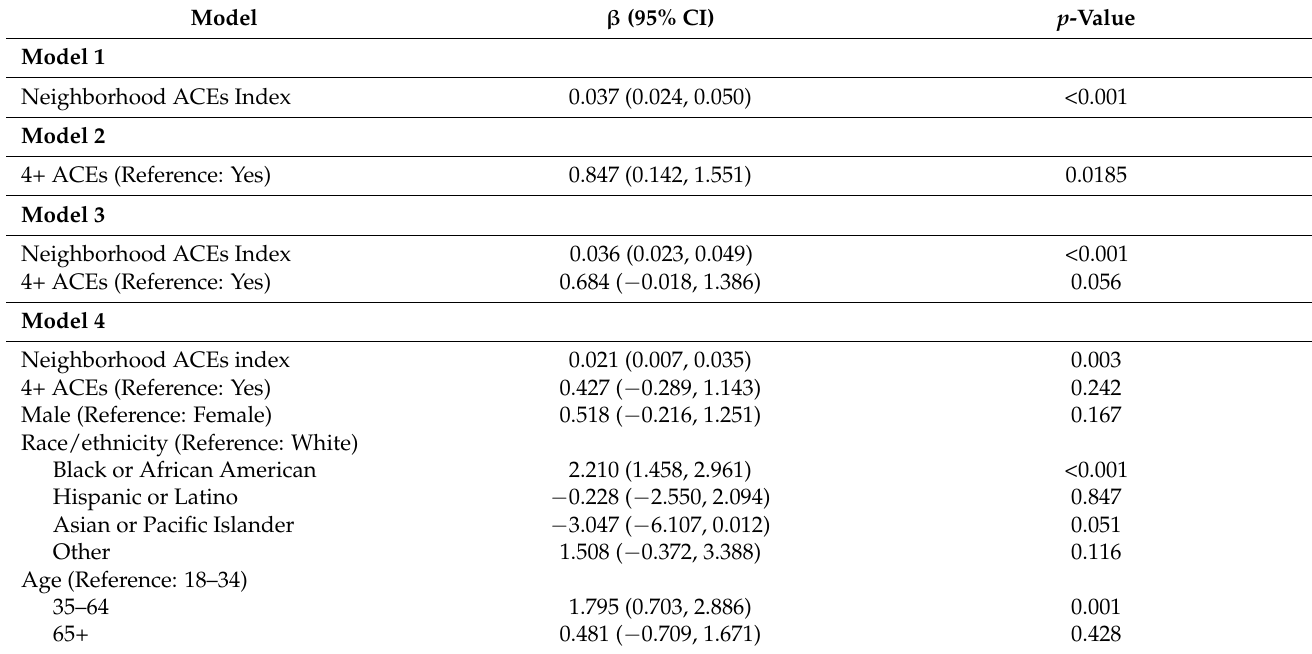
Table 3. Results of models examining associations of neighborhood ACEs index and ACEs with